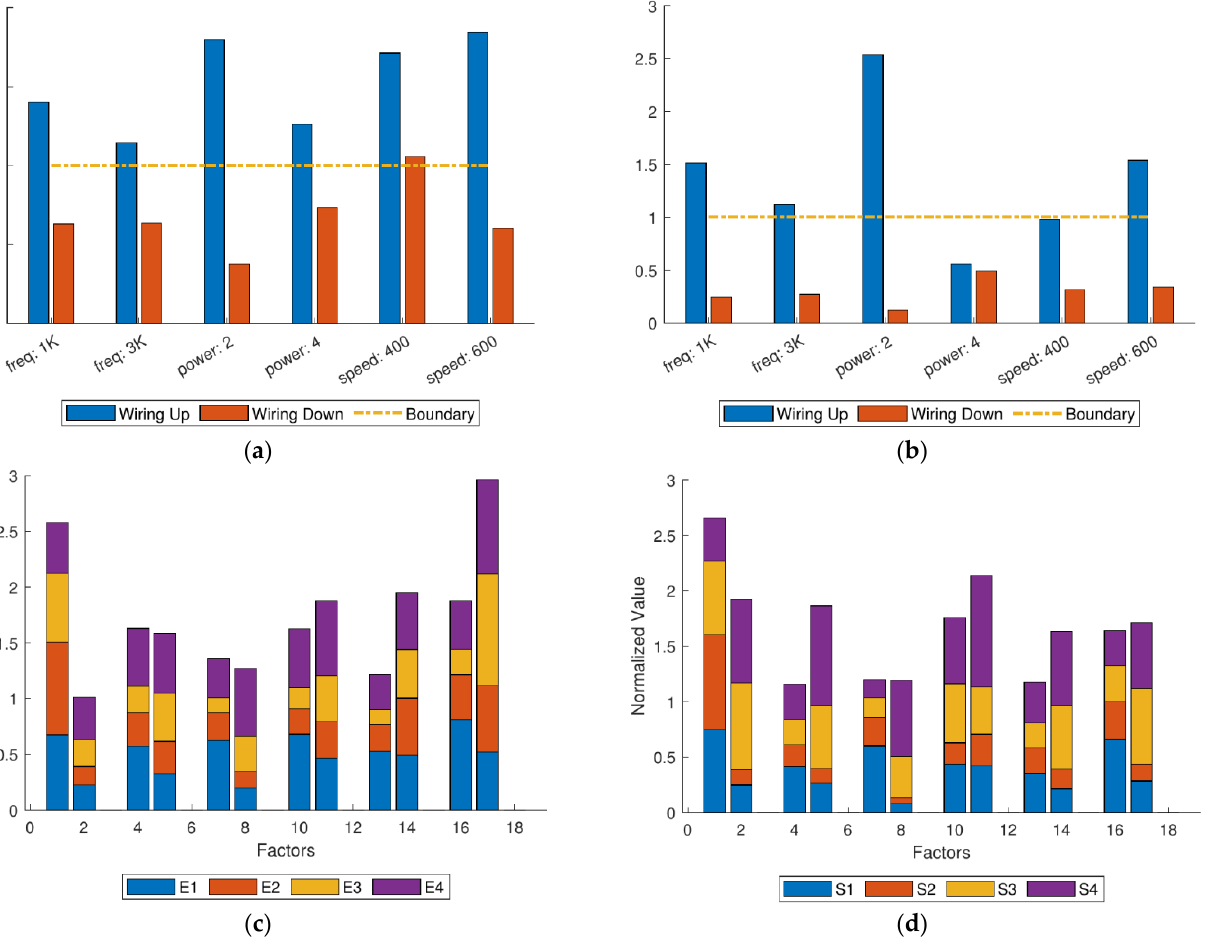
Figure 13. ( a ) E up : E down with different wire directions; ( b ) S up : S down with different wire directions; ( c ) energy distribution; ( d ) area distribution.